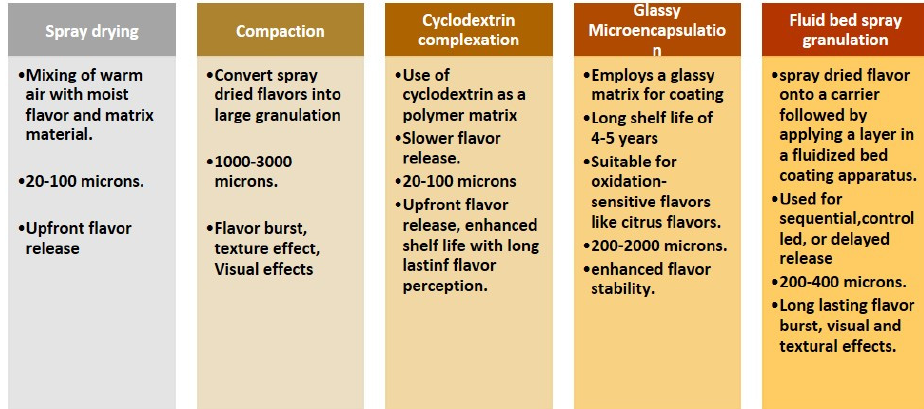
Figure 4. Properties of Flavor Microencapsulates from different techniques.